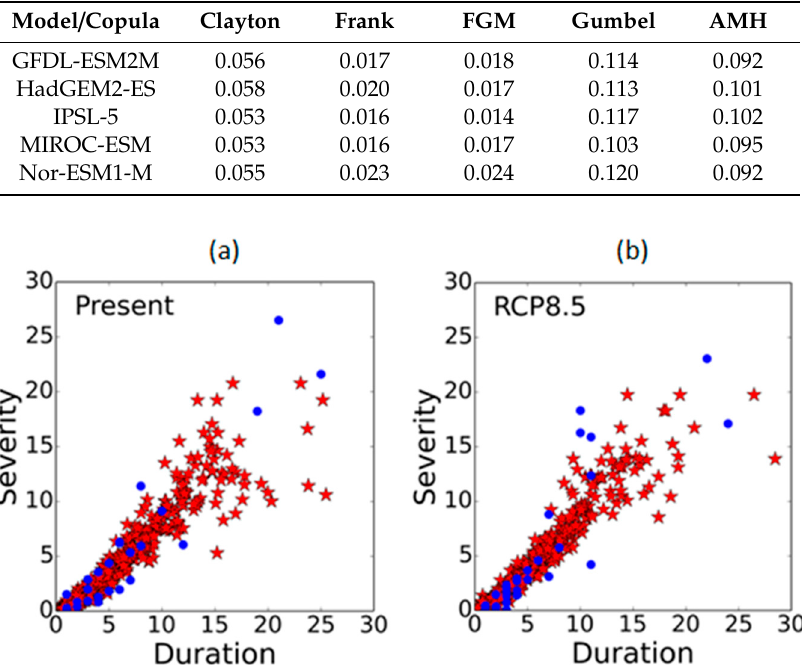
Figure 2. Comparison of calculated dependence (blue points) and simulated dependence (red points) from fitted by the Frank copula model for present ( a ) and end-century ( b ) period for the driving model GFDL-ESM2M.